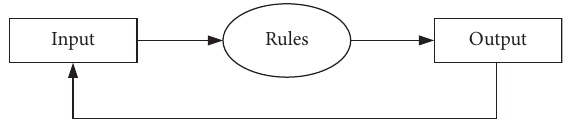
Figure 1: Information processing model of complex system